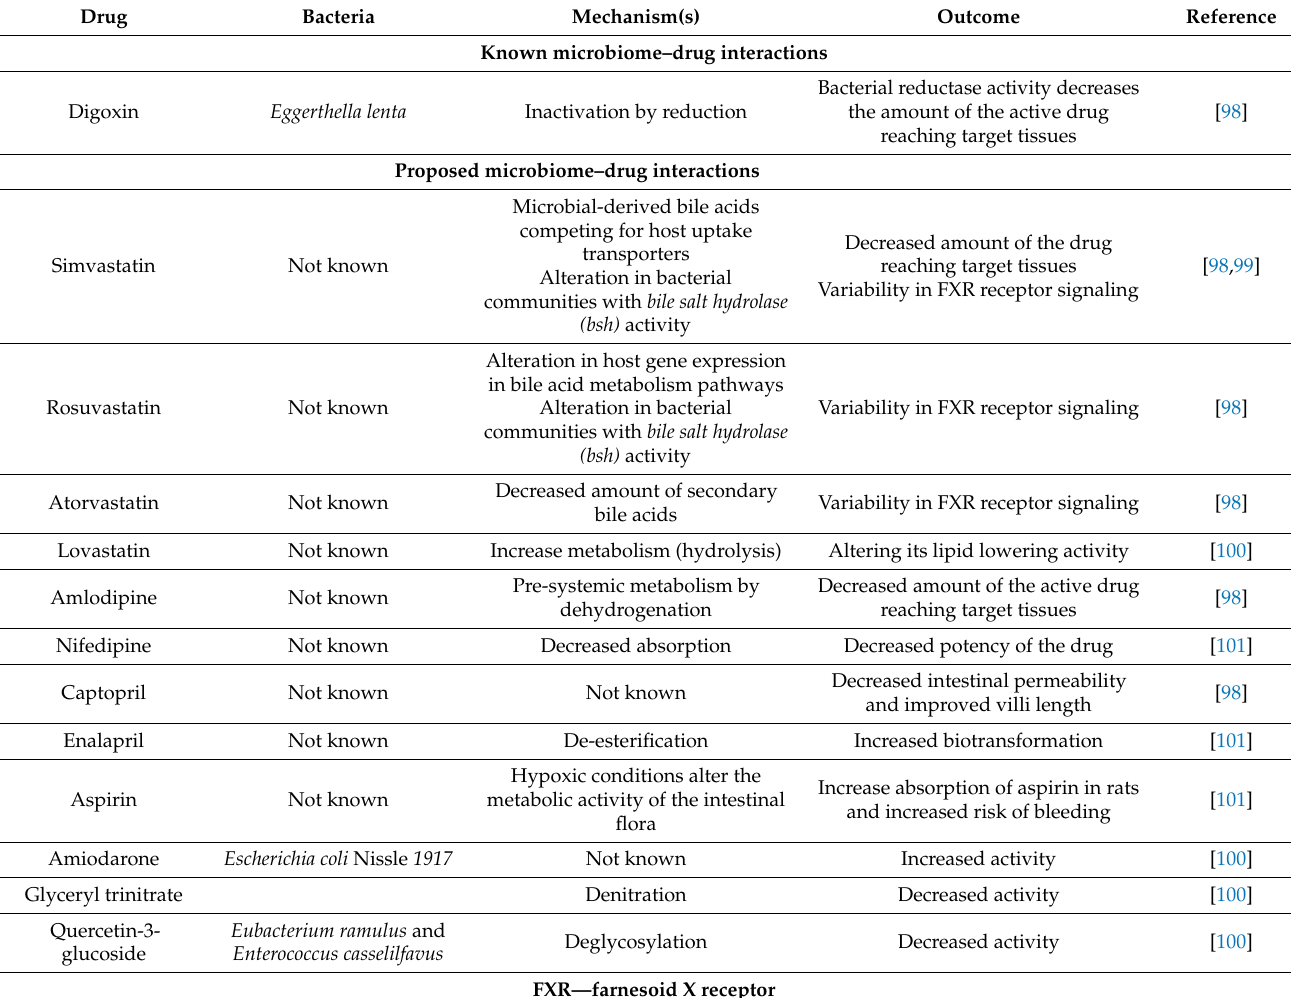
Table 3. Mechanisms by which the gut microbiota may influence cardiovascular drug